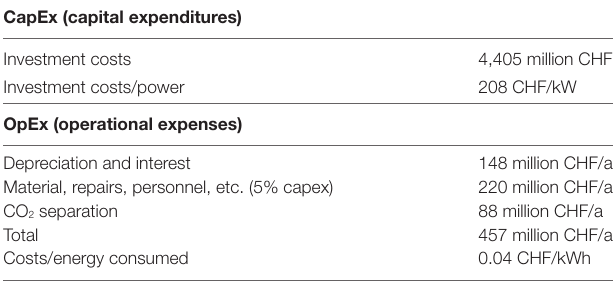
TaBle 8 | The costs of methanation at an installed capacity of 419